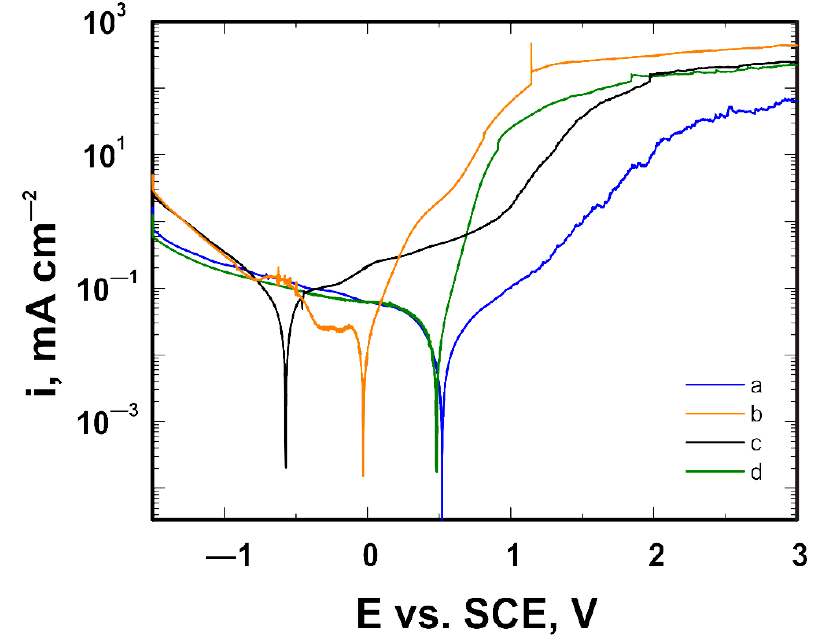
Figure 10. Potentiodynamic polarization curves analyzed in ( a ) artificial saliva solution, ( b ) simulated body fluid, ( c ) Hank’s solution and ( d ) Ringer’s solution , for Ti13Nb13Zr coated with the VTMS coating.